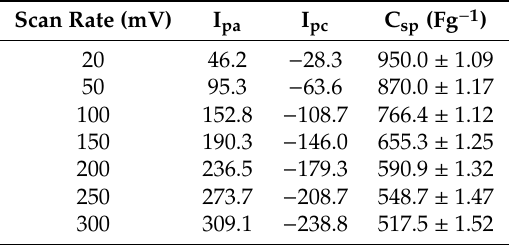
Table 4. Anodic peak current (I pa ), cathodic peak current (I pc ) and specific capacitance (C sp ) with standard error of P-5PA at various scan rates.